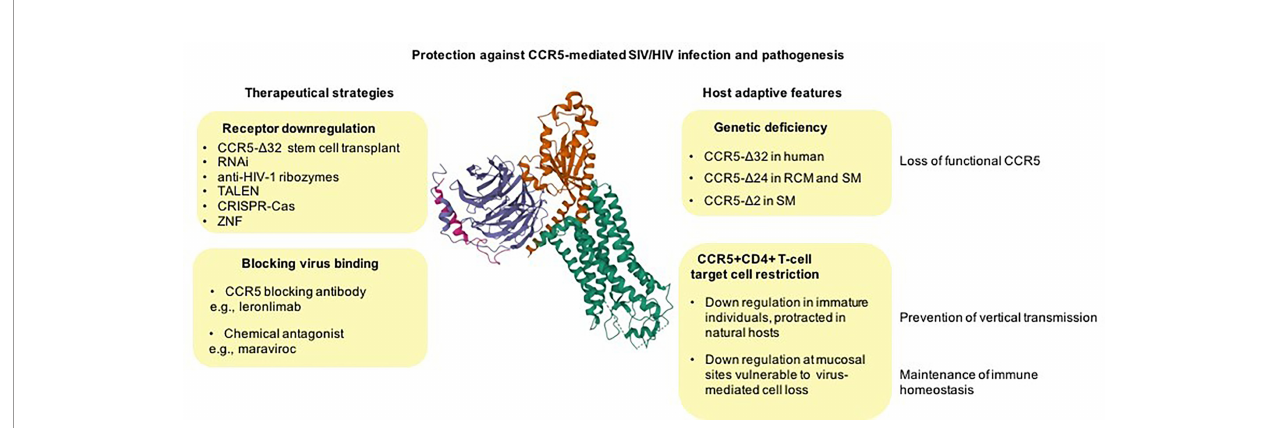
FIGURE 1 | From natural control of CCR5 activity to therapeutic approaches against HIV disease. CCR5 null alleles, preventing CCR5-mediated virus entry, naturally emerged and raised to high frequency in different primate species most likely as a result of host adaptation to lethal pathogens (unknown ancient pathogen in humans and SIV in natural hosts) (top right). CCR5 downregulation of CCR5 on CD4+ T-cells may be an adaptive feature of natural hosts protecting against the vertical transmission of the virus ( via breast feeding), and it may also represent an evolutionary adaptation to spare essential CD4+ T-cell subsets from killing by the virus (bottom right). Examples of approaches for therapeutic disruption of CCR5 expression include natural CCR5 gene knockouts (resulting in functional cure), programmable nucleases, and gene silencing (top left) and approaches to blocking the virus fusion with cell membrane via chemical CCR5 receptor antagonists or antibodies (bottom left). Cryo-EM structure of the chemokine receptor CCR5 (green) in complex with RANTES and guanine nucleotide-binding protein Gi subunits alpha-1 (red), beta-1 (blue), and gamma-2 (magenta) was acquired from https://www.rcsb.org/3d-view/7F1R/1 wwPDB: Worldwide Protein Data Bank (13, 31,